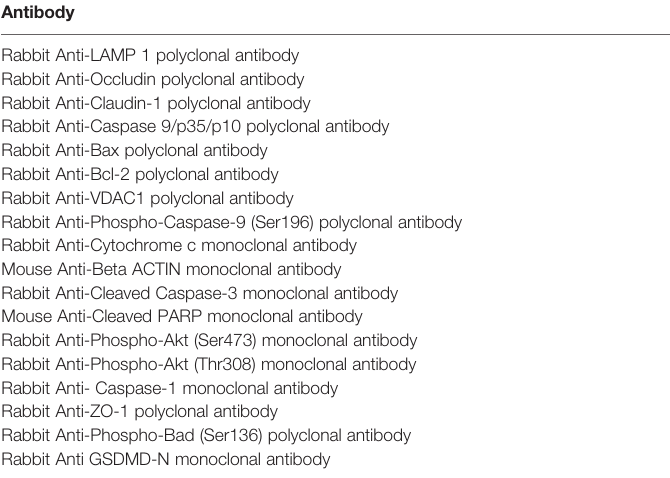
TABLE 2 | The dilution ratio of primary antibodies. Antibody Dilution rate Rabbit Anti-LAMP 1 polyclonal